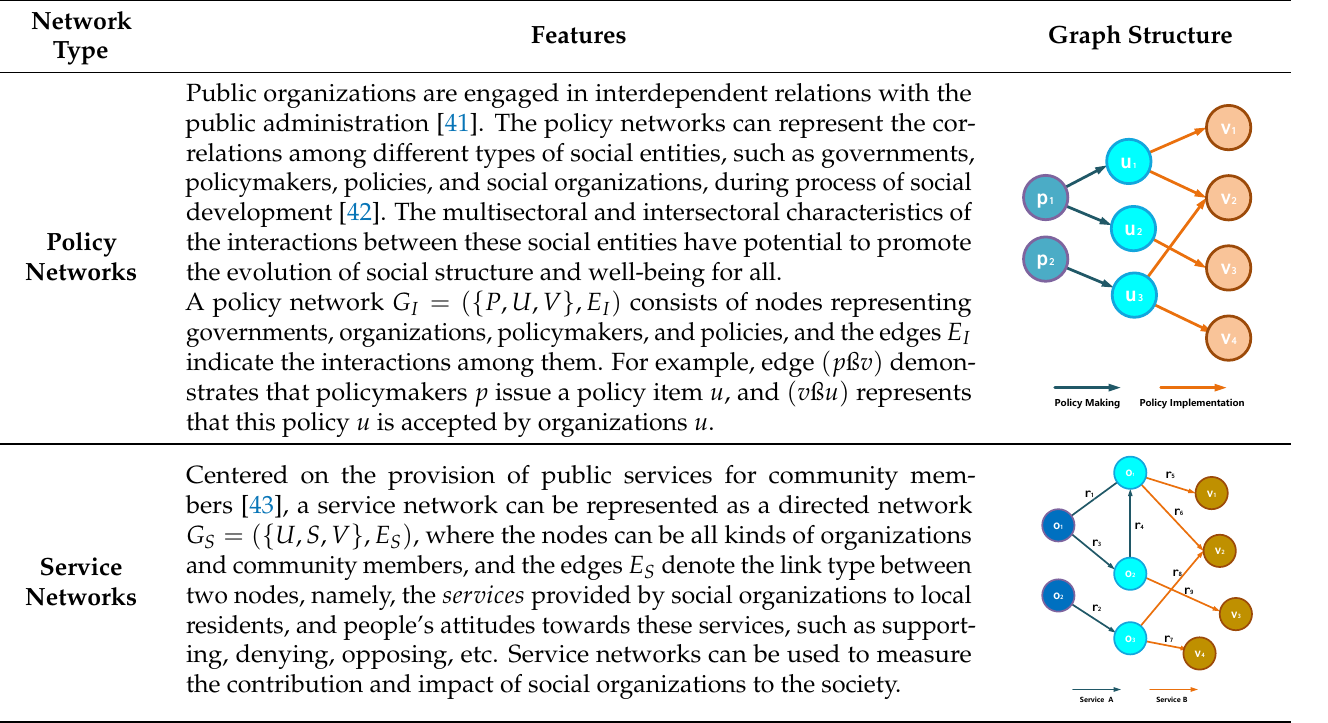
Table 5. Heterogeneous networks.